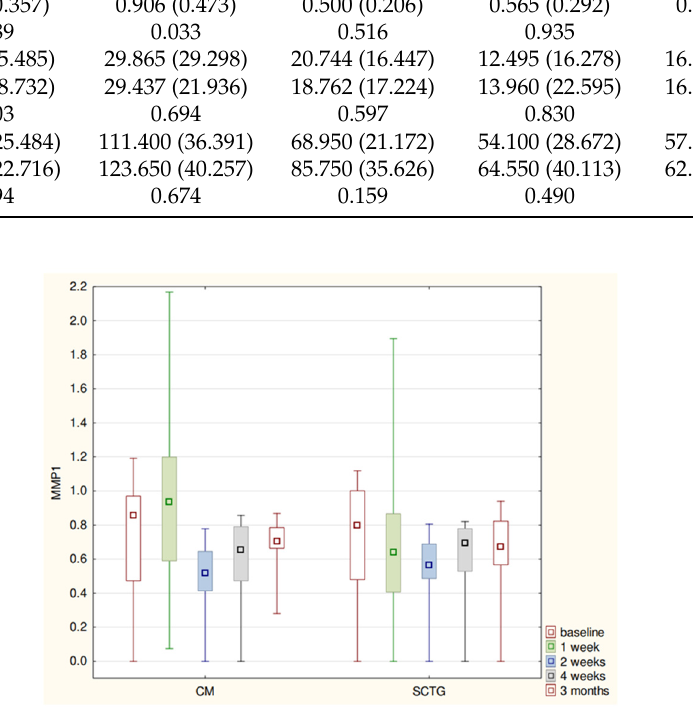
Figure 2. MMP8 levels (median-quartiles-range) at relevant stages of study. Over the period of three months we observed statistically significant reductions in gingival recession and recession width after both techniques. Those changes, however, had no significant impact on differences in GR, MRC, GRred, and RW between the sides. Simultaneously, there were increases in KT and GT on both sides. All of them were significant except KT on CM side. The analysis of those parameters between the groups showed a statistically significant difference in GT in favor of the SCTG side (Table 2). Table 2. Clinical parameters over 3-month observation. Baseline